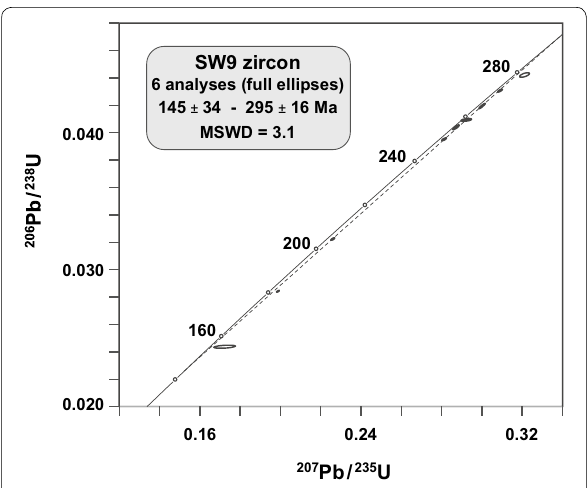
Fig. 8 Concordia diagram. Ellipses around individual data points indicate 2σ uncertainty. Upper intercept age of 295 interpreted to reflect granulite facies metamorphism. The significance of the lower intercept is more uncertain; it is possible that isotopic resetting could have been caused by the processes related to Jurassic hyperextension, with further disturbances during the Alpine events